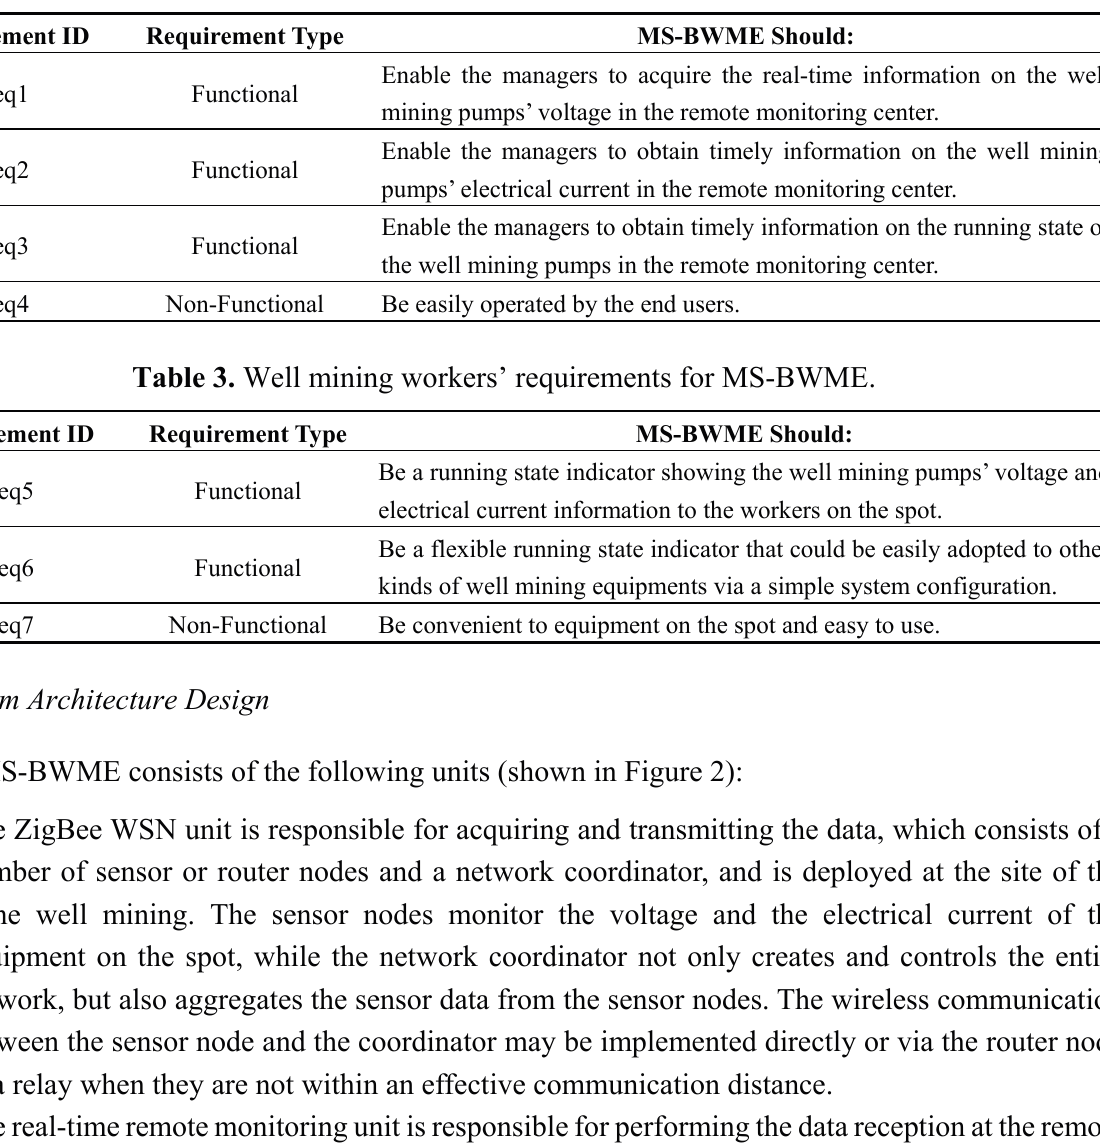
Table 2. Production managers’ requirements for MS-BWME.